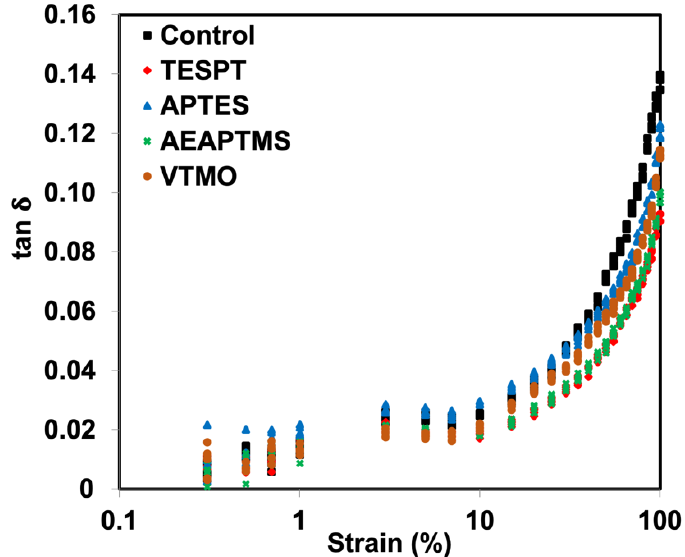
Figure 6. tan 𝛅 of NR/HNT composites filled with and without silane coupling agents. Figure 6. tan δ of NR/HNT composites filled with and without silane coupling